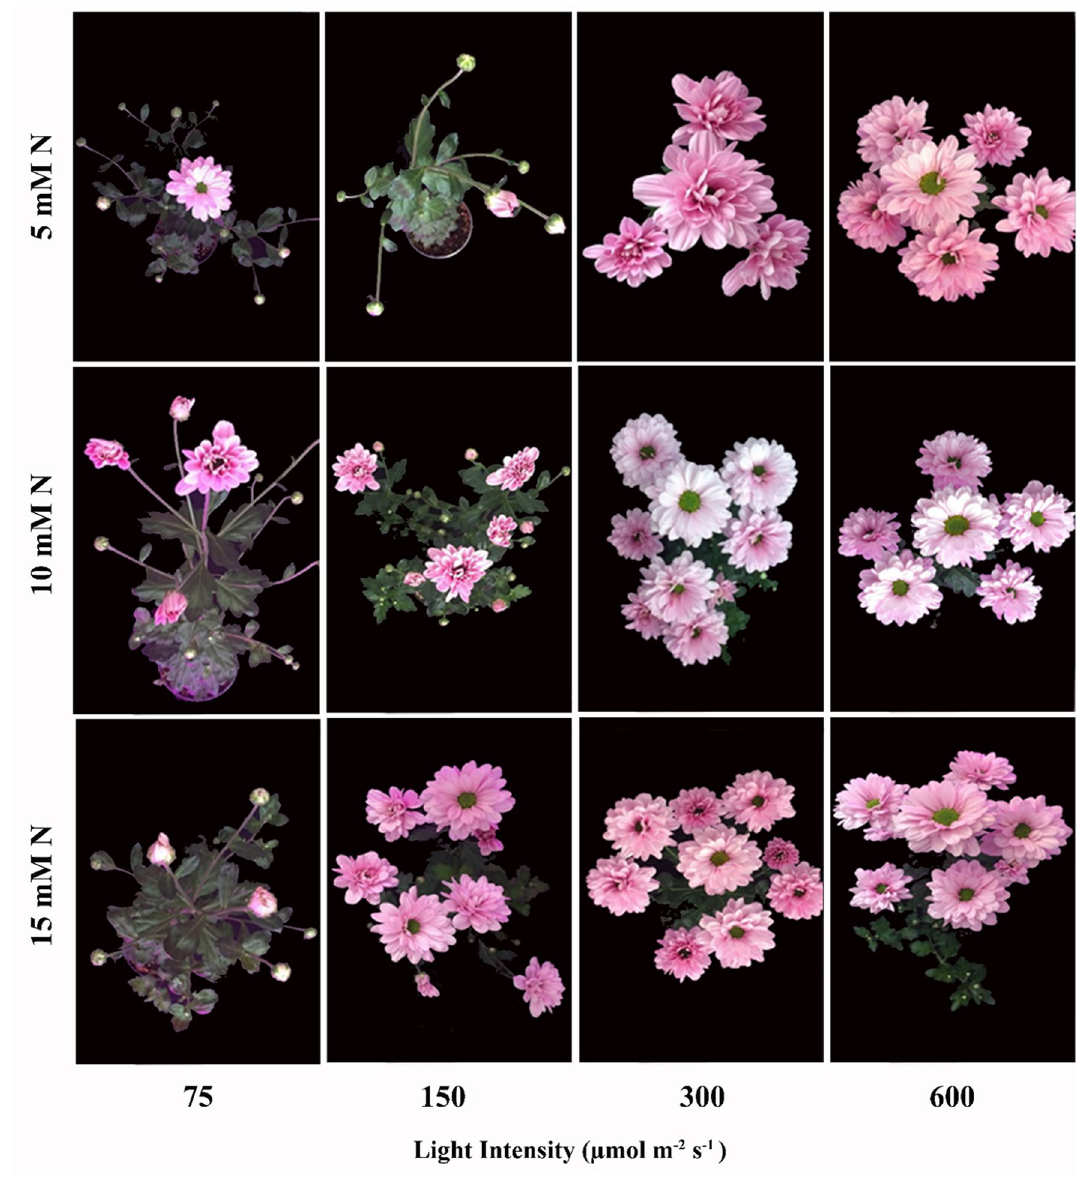
Figure 5. Interaction effect of light intensity and concentration of nitrogen (N) on the flowering of chrysanthemum. Plants were exposed to different concentrations of nitrogen (N) (5, 10, and 15 mM N) and light intensities (75, 150, 300, and 600 µmol m −2 s −1